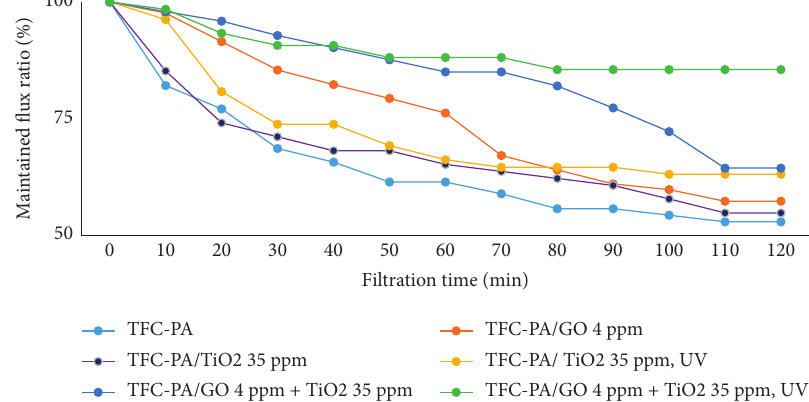
2 -coated membranes with UV